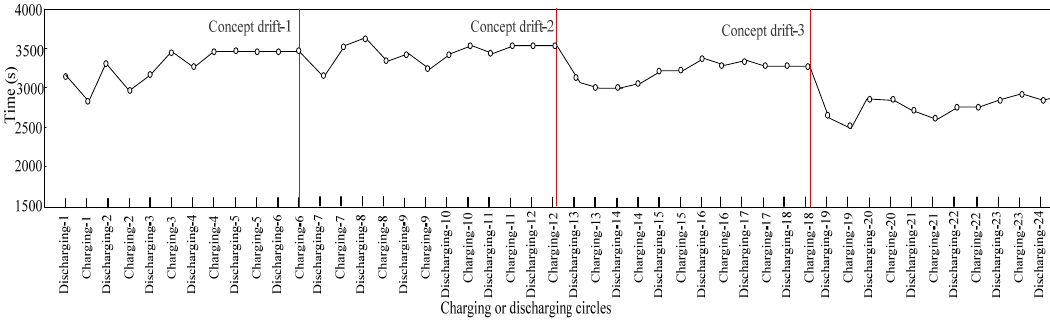
Figure 10. The balancing time for each discharging/charging